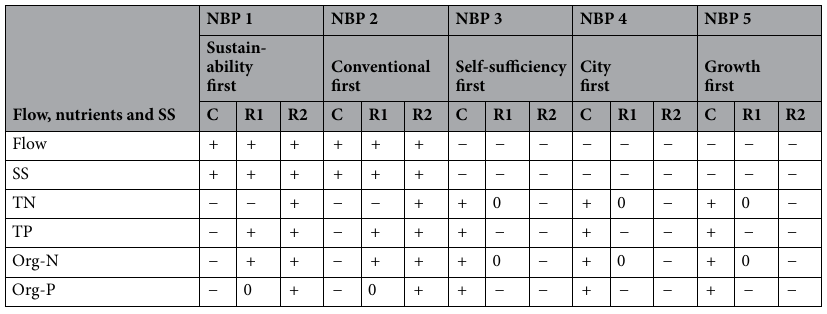
Table 1. Summary results of each NBP compared to NBP 0, for Catchment management strategy attribute from Stakeholders (CMS-STK). C represents the period from 1990 to 2015, as same as the baseline scenario’s period, R1 represents attribute + RCP–4.5 from 2031 to 2070, and R2 shows attribute + RCP–8.5 from 2031 to 2070. The symbol ‘0’ represents no change, ‘ + ’ represents an increase of the scenario up to 10%, and ‘-’ represents a decrease up to